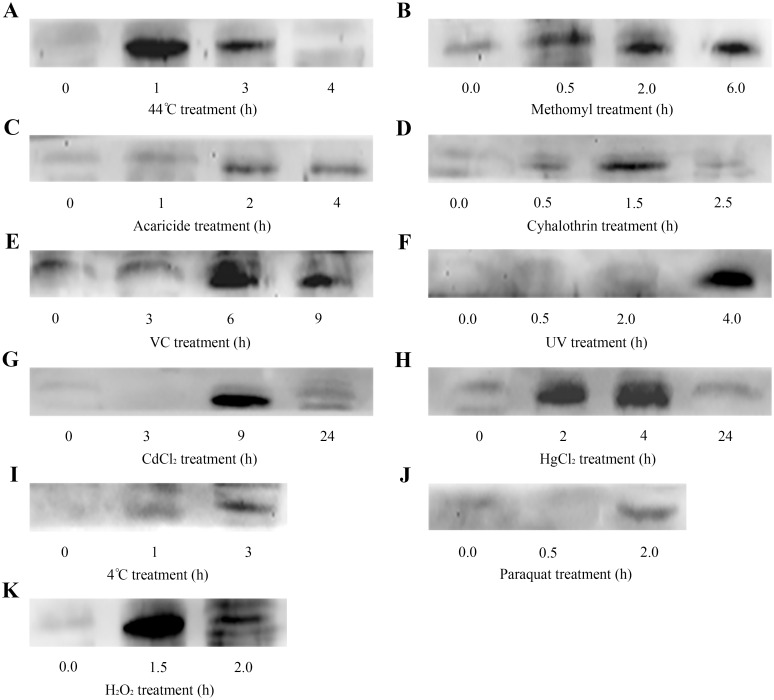
Western blot analysis of AccDpp.Fifteen-day-old adult bees were exposed to 44°C (A), methomyl (B), acaricide (C), cyhalothrin (D), VC (E), UV (F), CdCl2 (G), HgCl2 (H), 4°C (I), Paraquat (J), and H2O2 (K). An equivalent concentration of extracted protein was loaded in every lane under the same treatment conditions.